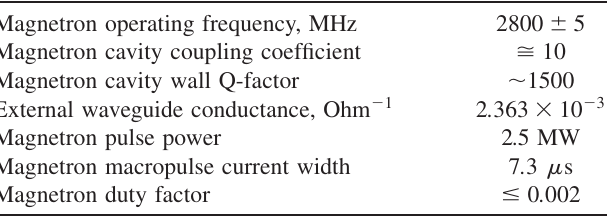
TABLE I. The magnetron main